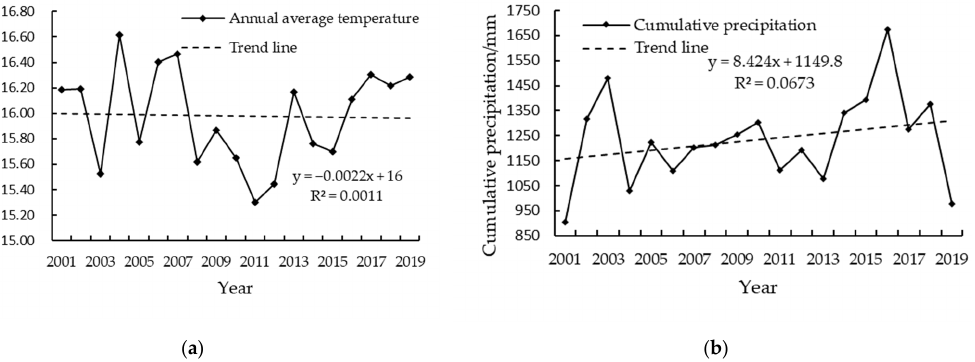
Figure 8. Annual average temperature ( a ), and cumulative precipitation ( b ), in Anhui Province from 2001 to 2019.